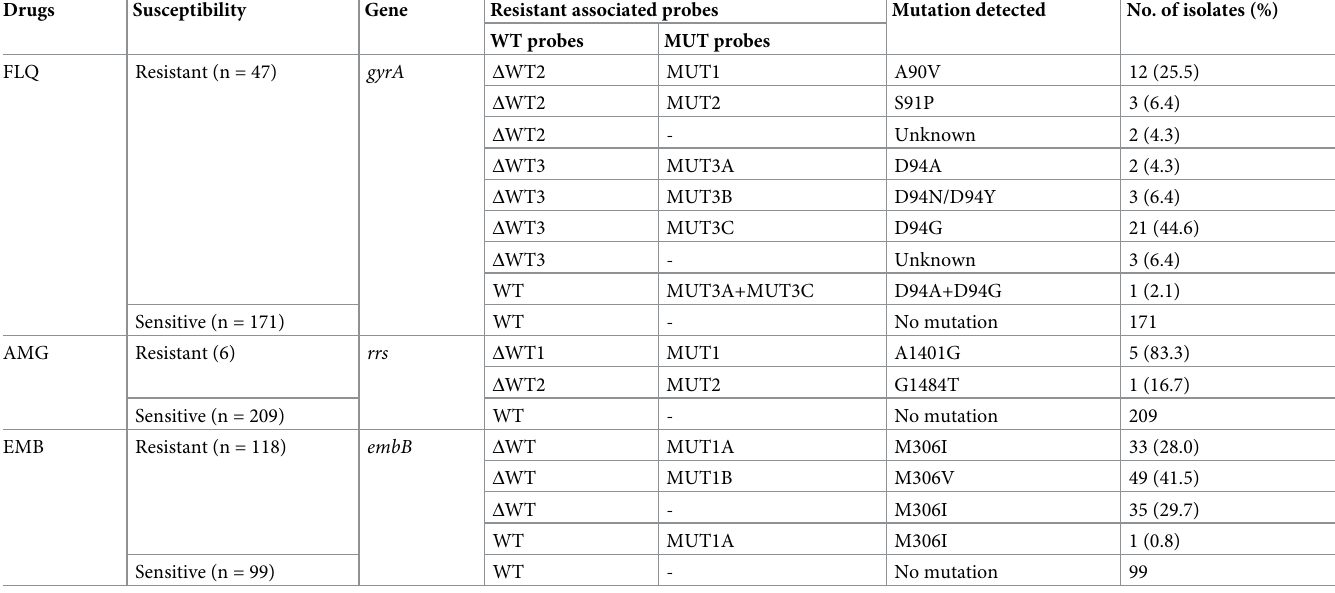
Table 4. Mutation pattern of gyr A, rrs , and emb B genes obtained by MTBDR sl assay using the sputum specimens from MDR-TB patients.